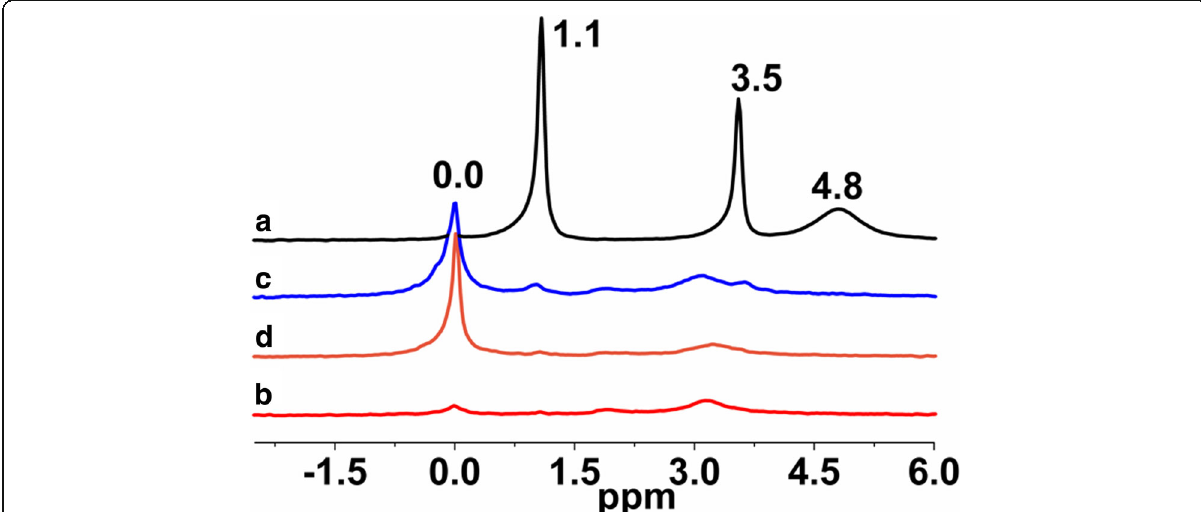
Fig. 13 1 H MAS NMR spectra of ( a ) neat fumed silica, ( b ) modified fumed silica with neat CPDMS, modified with ( c ) mixtures of CPDMS and dimethyl carbonate and ( d ) mixtures of CPDMS and diethyl